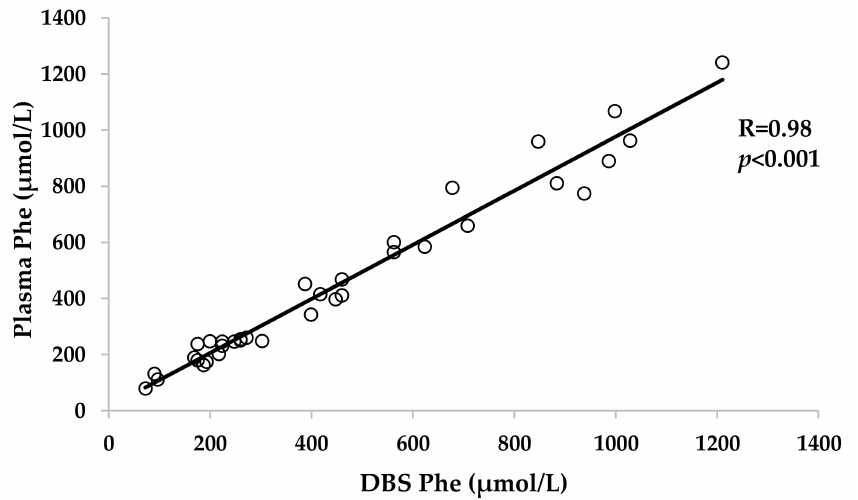
Figure 3. Correlation between the concentration of phenylalanine in plasma and in DBS in mHPA/PKU patients. Mild hyperphenylalaninemia (mHPA), phenylketonuria (PKU), dried blood spot (DBS), phenylalanine